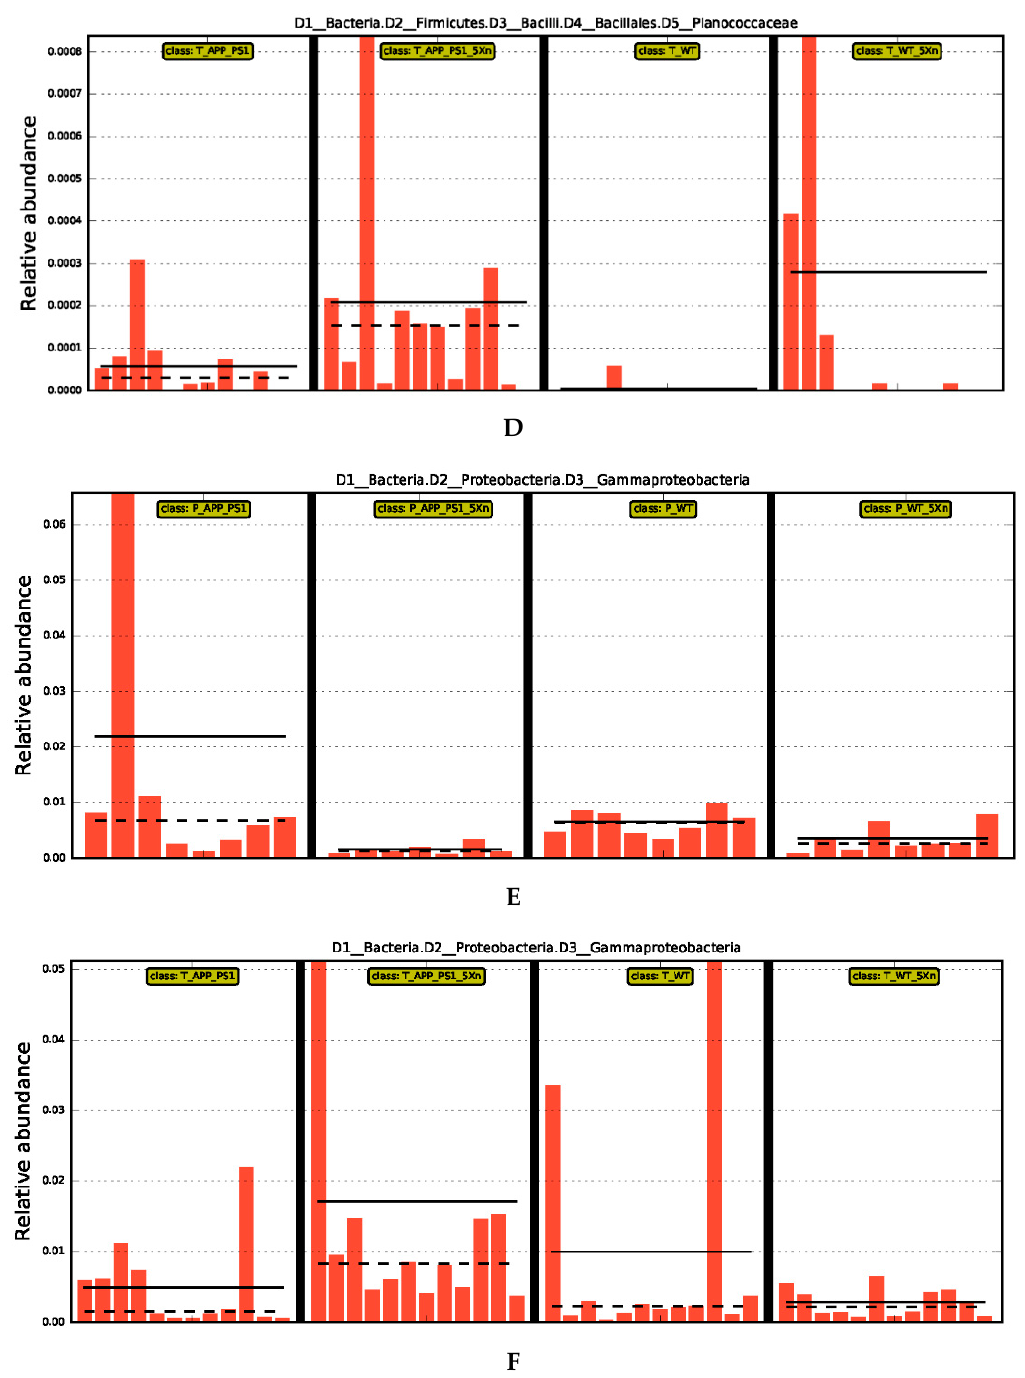
Figure 3. Abundance histogram of three representative differential species. ( A,C,E ) Different species in the prevention experiment. ( B,D,F ) Different species in the therapy experiment. The X-axis represents different groups, the Y-axis represents the relative abundance of different species, and the orange bars with different lengths indicate the relative abundance of different species in each sample. In the groups of each mini-graph, the solid line represents the mean value within the group, and the dashed line represents the median value. LDA score was used to assess the impact of significantly differential species. The larger the score, the bigger the impact. The pictures show different species with LDA Score greater than 2.0. LDA, Line Discriminant Analysis.